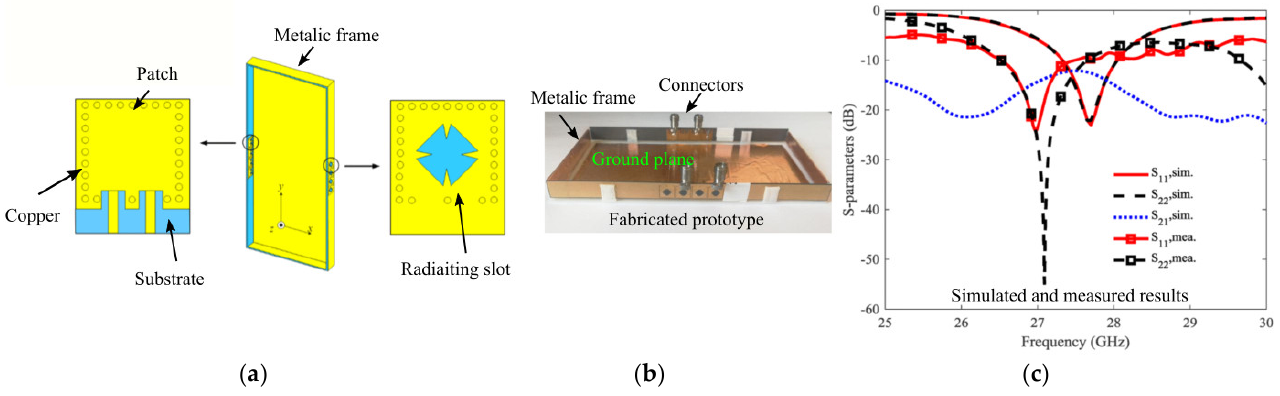
Figure 13. Dual − polarized frame integrated slot array [93] ( a ) configuration of the antenna array, ( b ) photo of the fabricated antenna, and ( c ) simulated and measured S − parameters.